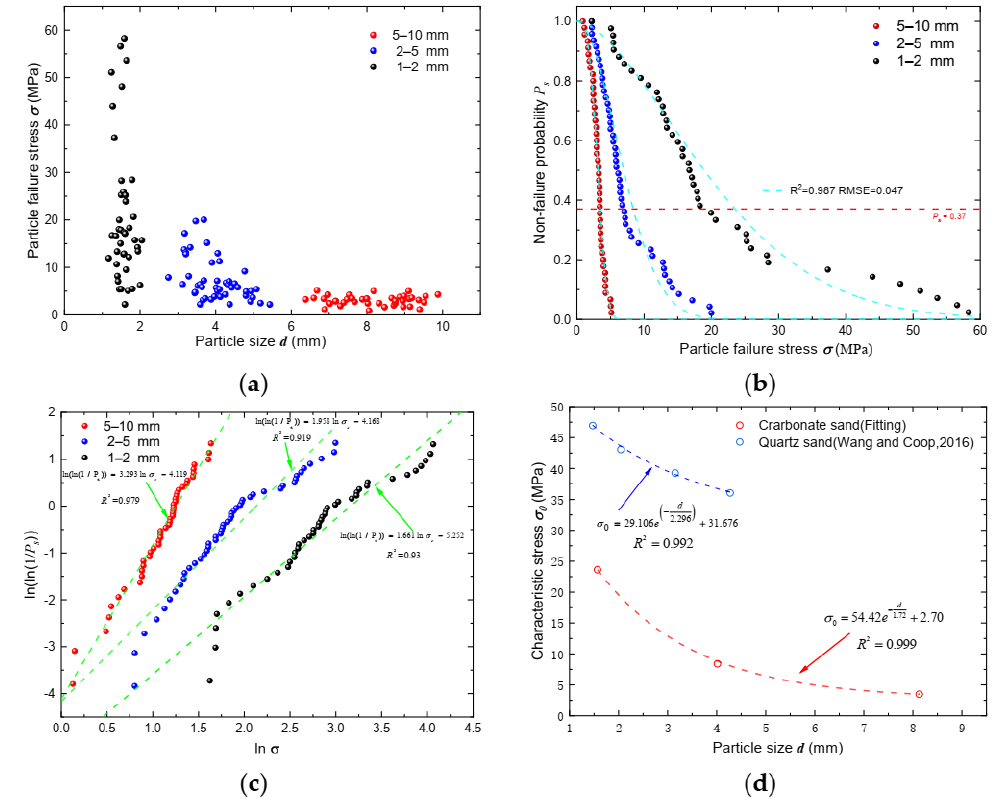
Figure 9. ( a ) Failure stress versus particle size plot; ( b ) non-failure probability distribution curve; ( c ) Weibull distribution fitting results; ( d ) characteristic stress versus particle size plot for the three fractions of carbonate